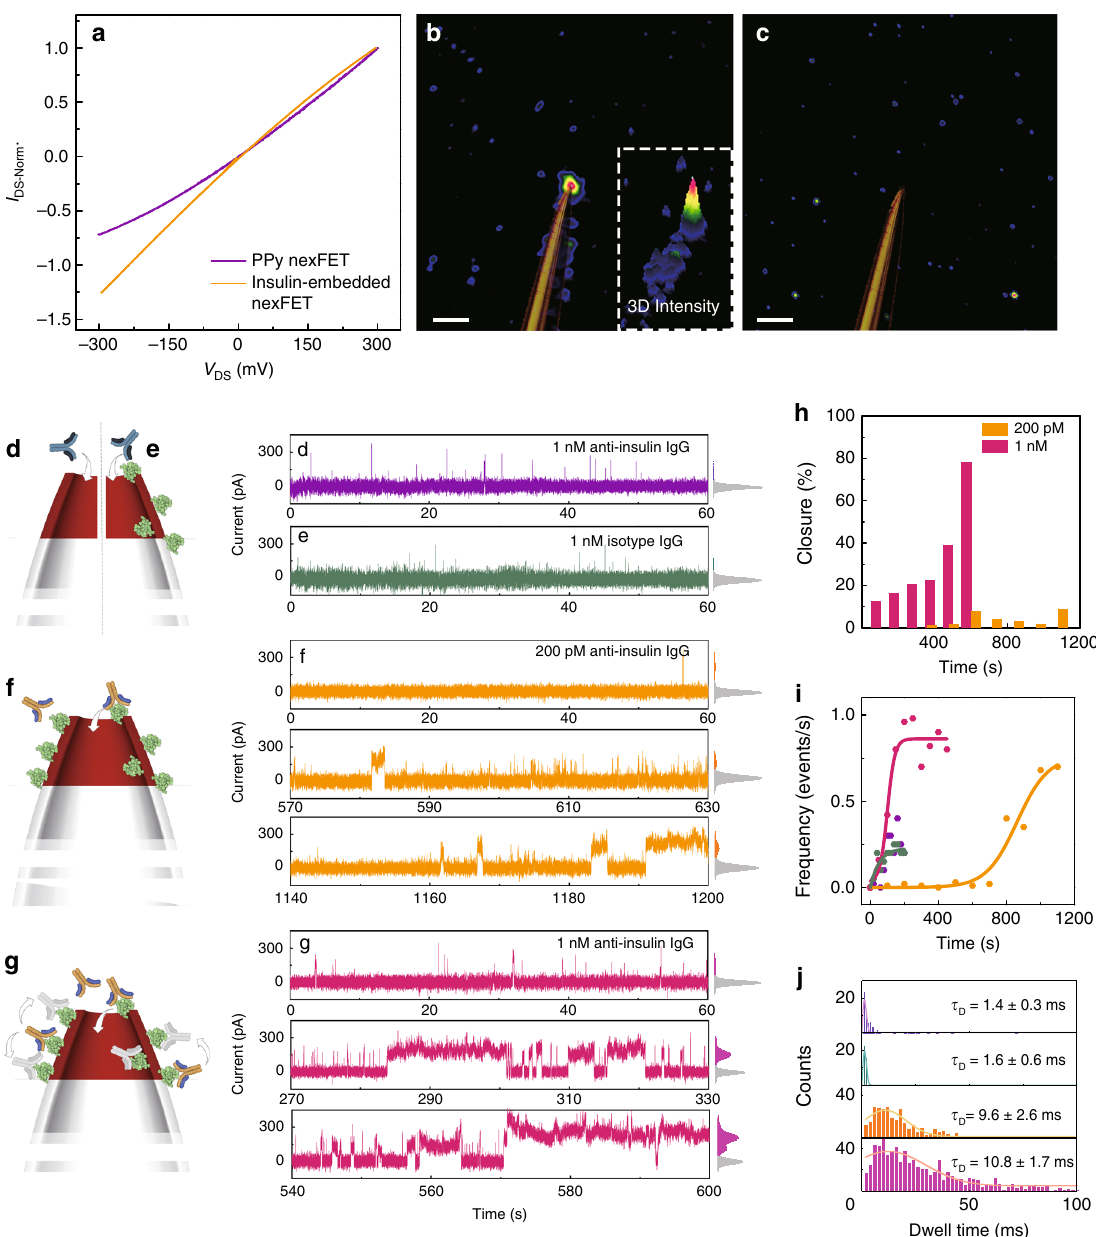
Fig. 5 Sensing of anti-insulin IgG antibody with insulin-embedded PPy nexFET. a Current-voltage curves for a nexFET with and without embedded insulin. b Fluorescence images superimposed with a white light image of the nanopipette con fi rming selective binding of the anti-insulin IgG antibody to insulin- embedded nexFET by using a fl uorescently labeled secondary antibody, c and no binding without insulin present ( scale bars , 10 μ m). d – g Schematics of the proposed translocation mechanism and corresponding current-time traces. Current-time trace for the translocation of d , 1 nM anti-insulin IgG antibody through a nexFET without embedded insulin, and e 1 nM isotype IgG antibody through an insulin-embedded nexFET. Concentration and time dependence for the translocation of anti-insulin IgG in the presence of an insulin-embedded nexFET is shown in f for 200 pM and g 1 nM, respectively. For all traces, an all points current histogram is shown on the right-hand side. Histograms of h the closure ratio, i frequency of translocation, and j mean translocation dwell times τ D are also